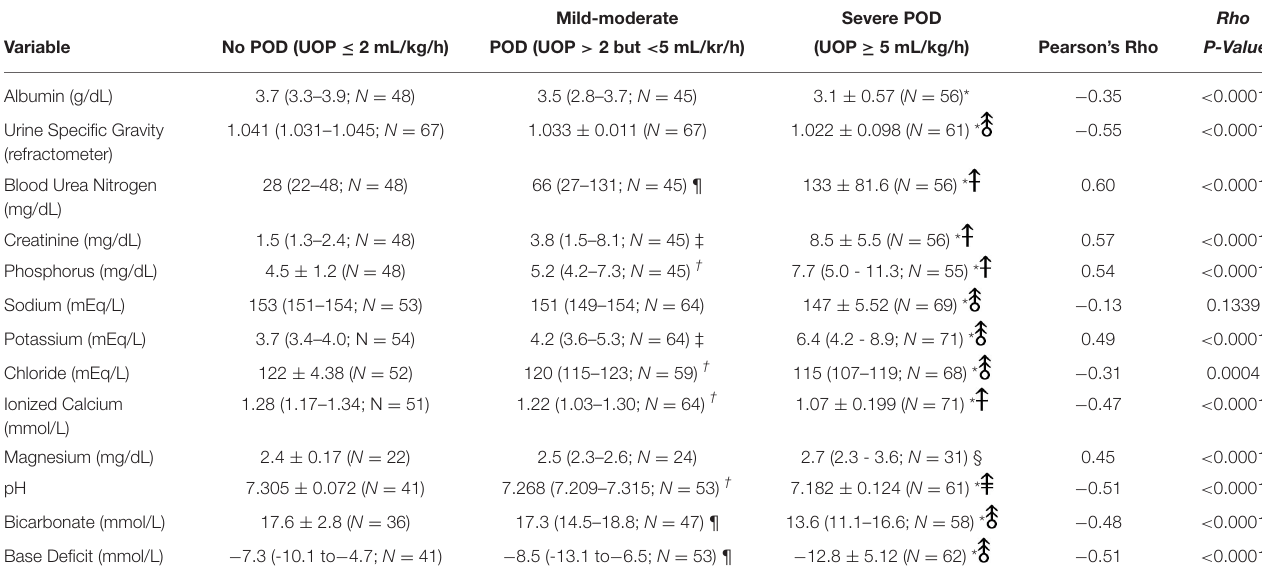
TABLE 1 | Presentation venous acid-base and electrolyte panel, serum biochemistry panel, and urinalysis values in adult male cats with urethral obstruction that did not develop post-obstructive diuresis (POD; N = 84/260), those that developed mild-to-moderate POD ( N = 85/260), and those that developed severe POD ( N = 91/260) following urethral